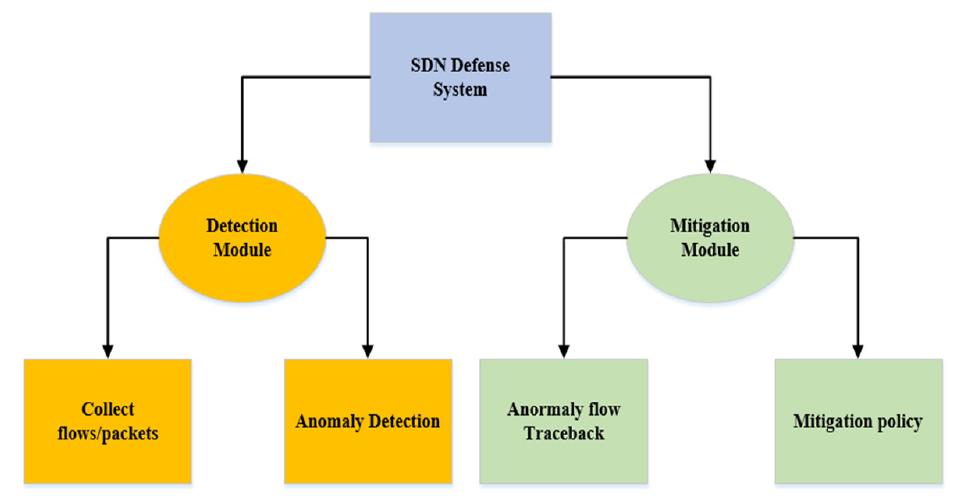
Figure 1. SDN security defense architecture module diagram.